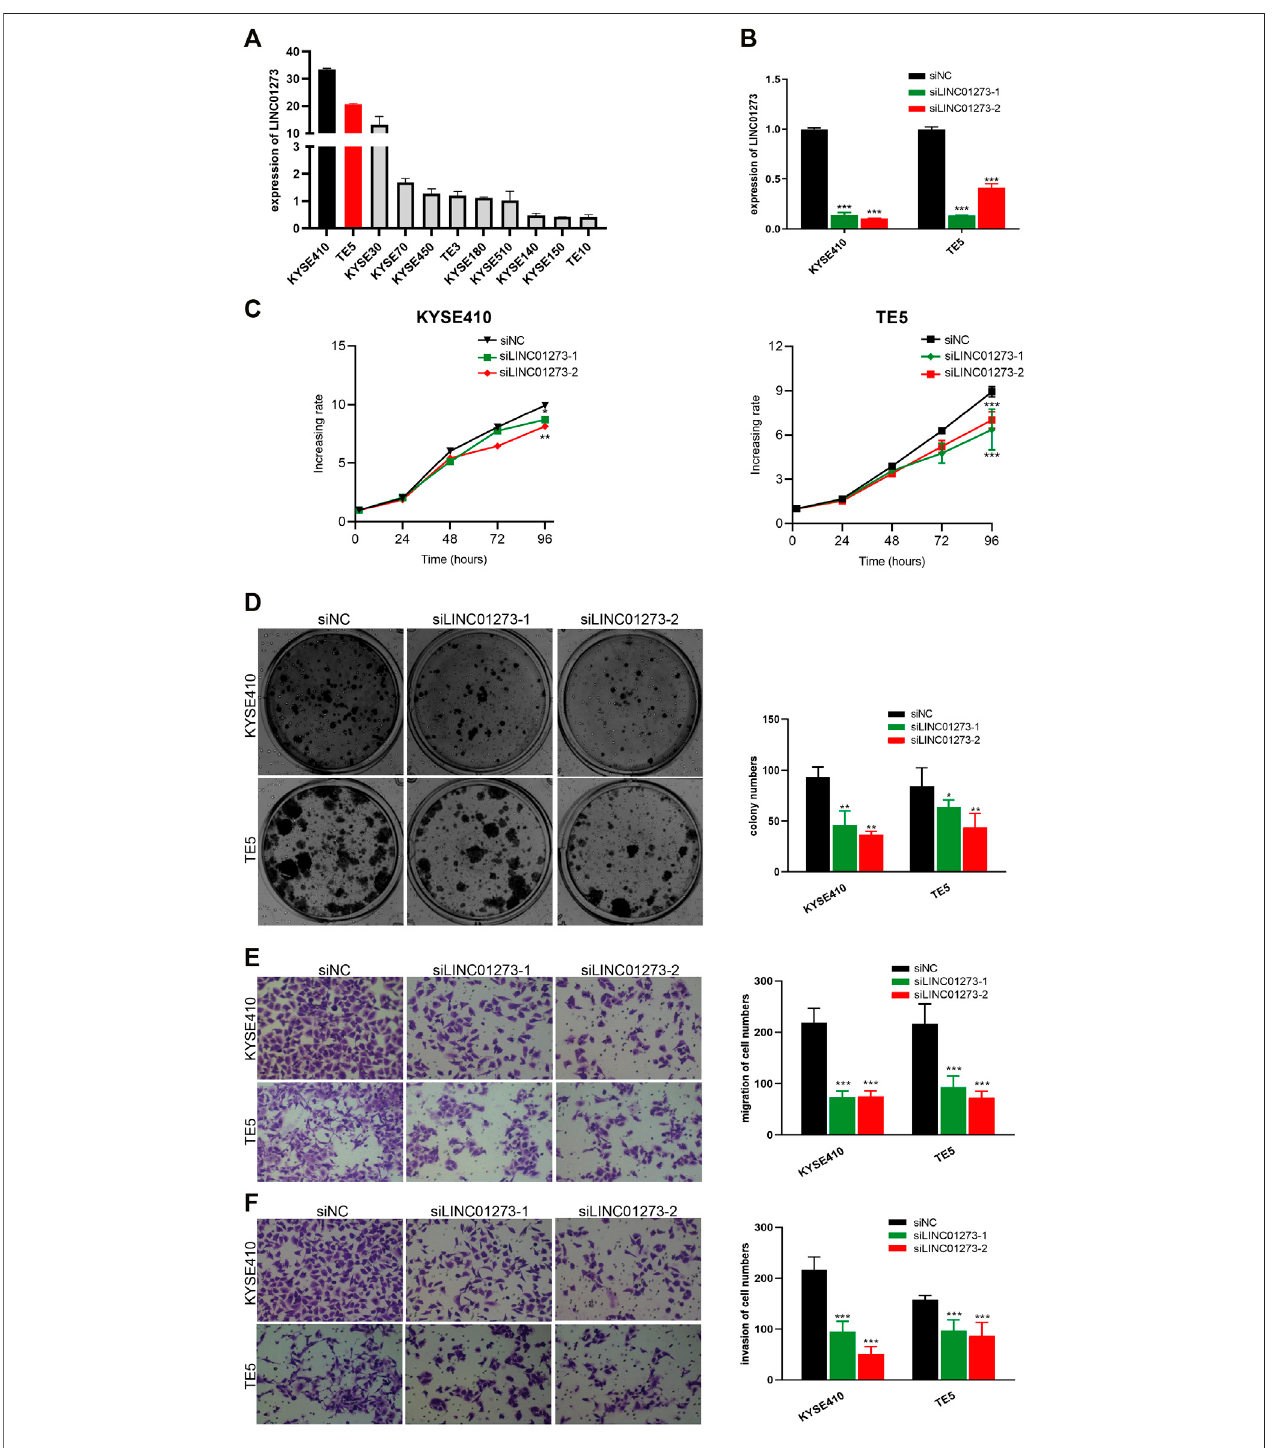
FIGURE 5 | Oncogenic effect of LINC01273 on ESCC cells. (A) RT-qPCR analysis of LINC01273 expression in ESCC cell lines. (B) siRNA-mediated silencing of LINC01273wasevaluatedbyusingRT-qPCR. (C,D) ResultsoftheMTSassay (C) andcolonyformationassay (D) demonstratedthatcellproliferationwasinhibitedafter depletion of LINC01273 in KYSE410 and TE5 cells. (E,F) Transwell assays suggested that migration (E) and invasion (F) abilities were reduced after LINC01273 knockdown. All data are expressed as mean ± SD (* p < 0.05, ** p < 0.01, *** p < 0.001).